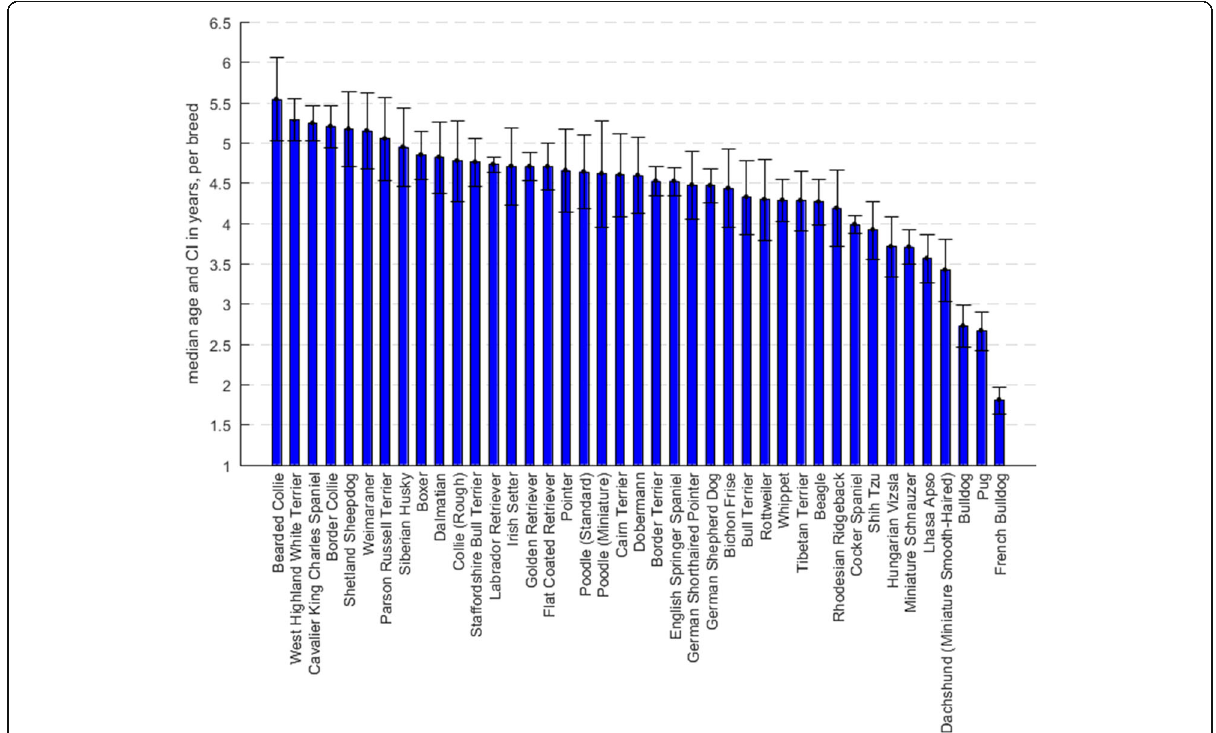
Fig. 1 Median age (and 95% confidence intervals) of the n = 41 breeds with responses on ≥ 200 unique